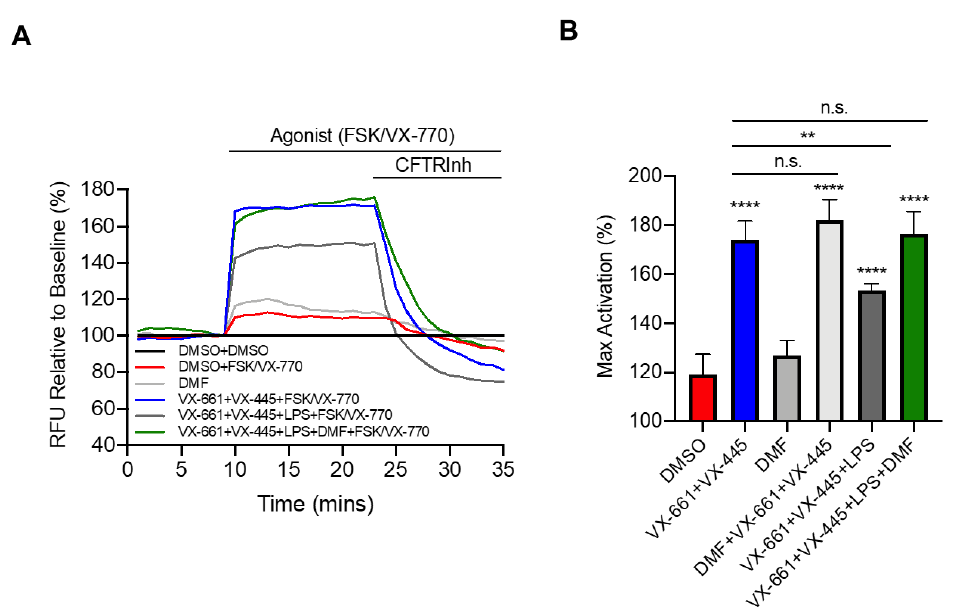
Figure 3. DMF restores VX-661 + VX-445 rescued F508del-CFTR function in CFBE cells. ( A ) Representative traces of F508del-CFTR channel activity using membrane depolarized assay. CFBE cells were treated with 0.1% DMSO, 50 µM DMF, 3 µM VX-661 + 3 µM VX-445, 3 µM VX-661 + 3 µM VX-445 + 50 µM DMF +/ − 10 µg/mL of LPS for 24 h. ( B ) Bar graphs show the mean (±SD) of maximal activation of CFTR in different treatment conditions after stimulation by 10 µM Forskolin (FSK) + 1 µM VX-770 ( n = 4). ** p < 0.01; **** p < 0.0001.